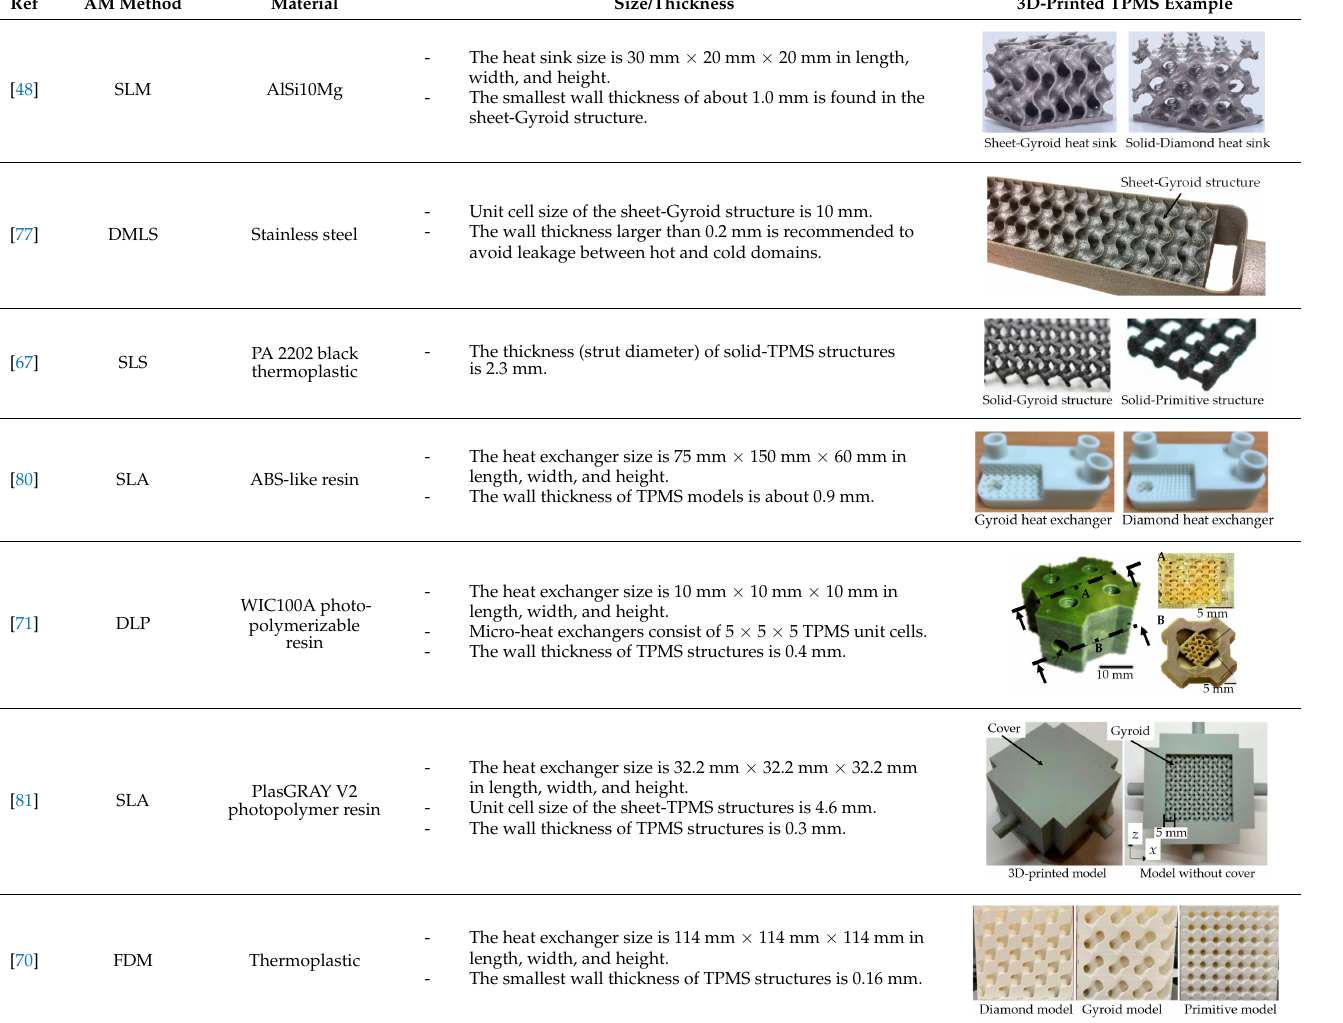
Table 2 . Overview of AM methods for fabricating TPMS-based cooling channels in recent studies. Ref AM Method Material